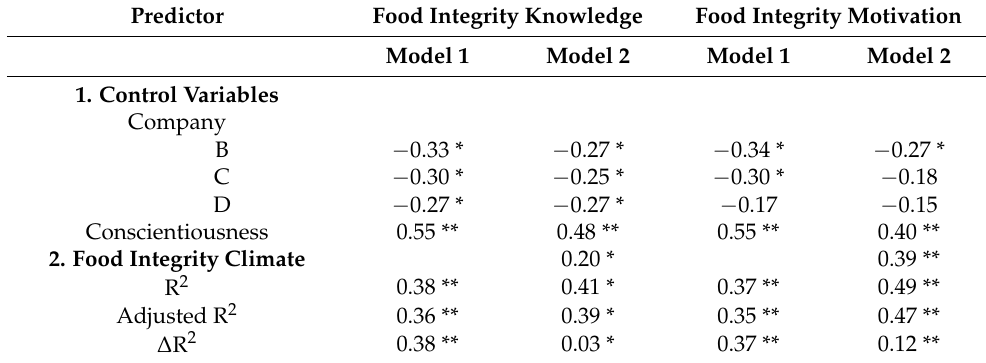
Table 6. Hierarchical linear regression of food integrity knowledge and food integrity motivation on control variables and food integrity climate (step 2 of the mediation analysis) ( n = 118 participants). Standardized regression coefficients for the respective regression steps are reported. Conscientious- ness and food integrity climate are centered around the mean (* p < 0.05, ** p < 0.01; Company A is reference category). Hypotheses 3A and 3B were confirmed, since the relation between food integrity climate and food integrity behavior was partially mediated by food integrity knowledge and fully mediated by food integrity